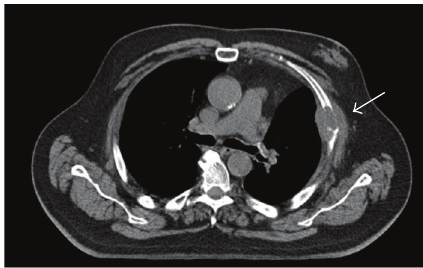
Figure 1: Computed tomography scan of the thorax showing left-sided local relapse in the pleura and thoracic wall after lobectomy. Status before palliative radiotherapy.